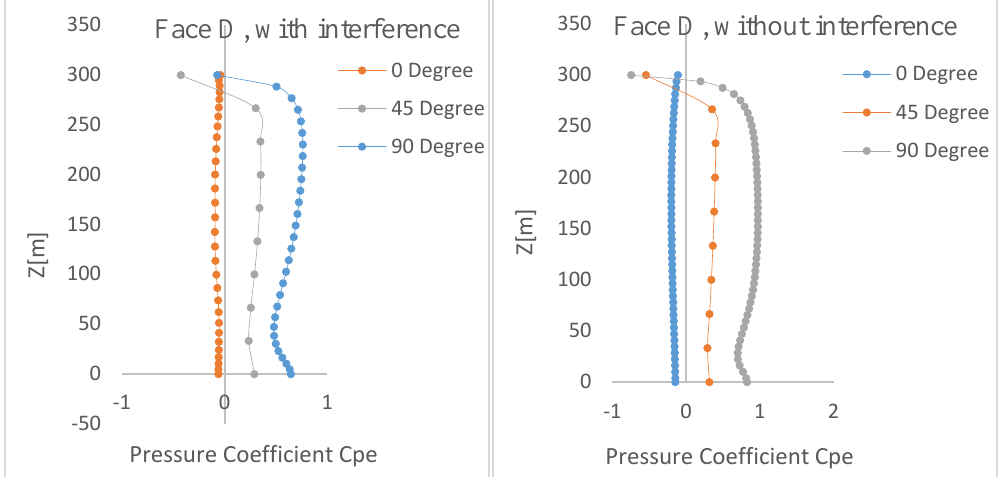
Fig. 9. Variation of pressure coefficient with height for Face D with Interference and without interference.